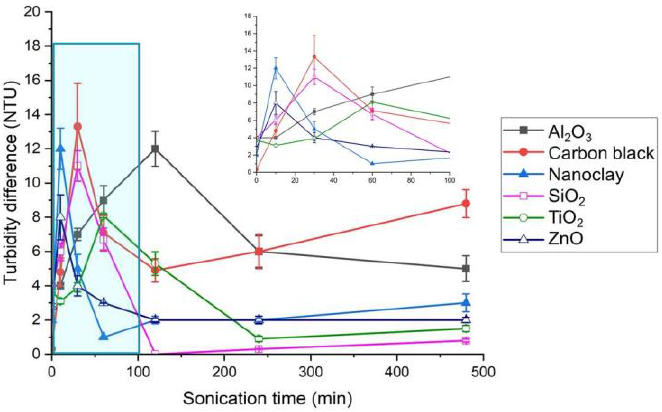
Figure 3. Turbidity difference by sonication